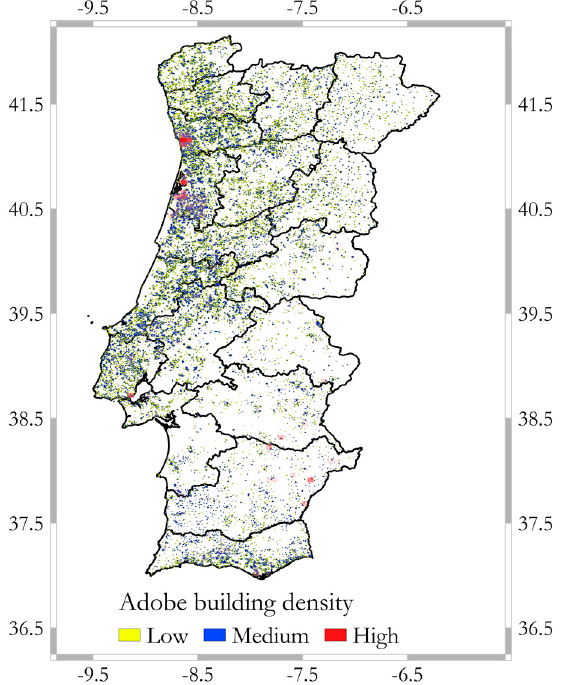
Figure 1. Geographical distribution of adobe buildings in Portugal, as reported in the INE 2011 [13].